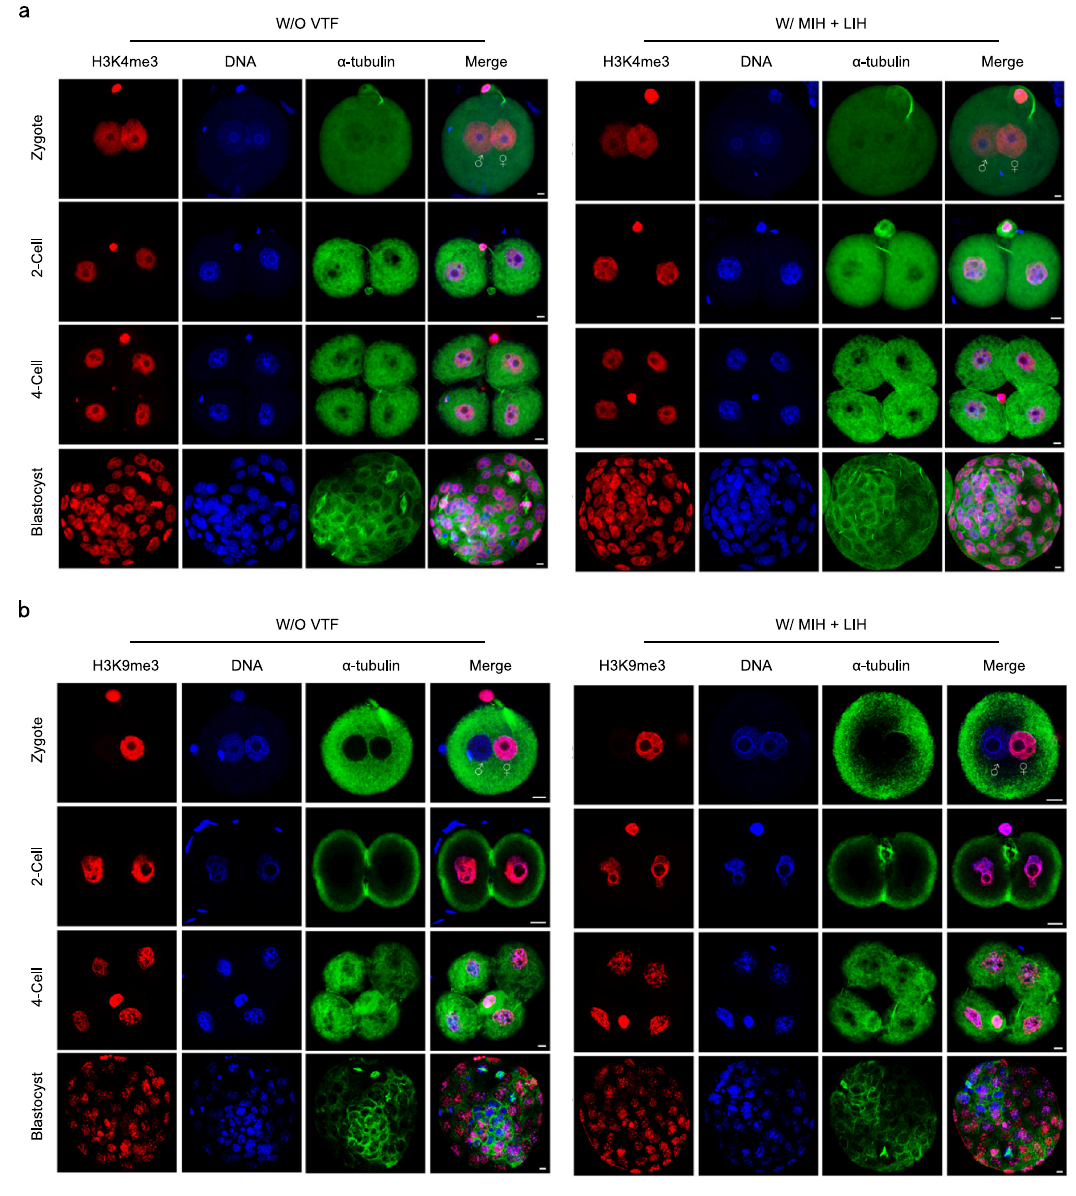
Fig.6|H3K4me3andH3K9me3inembryosatdifferentstages.a Representative images of H3K4me3 in embryos at different stages. b Representative images of H3K9me3inembryosatdifferentstages.Scalebaris10 μ m( a , b ).Eachexperiment wasrepeatedthreetimeswithsimilarresults,andrepresentativeimagesareshown